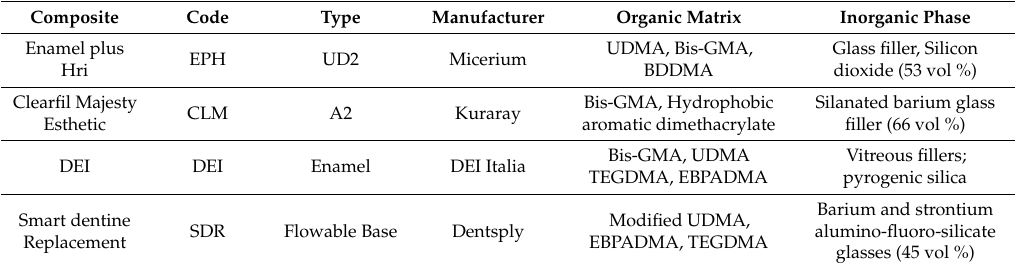
Table 1. Specifics and composition of the analysed restorative composites. The amount of particles is expressed as volume percentage.